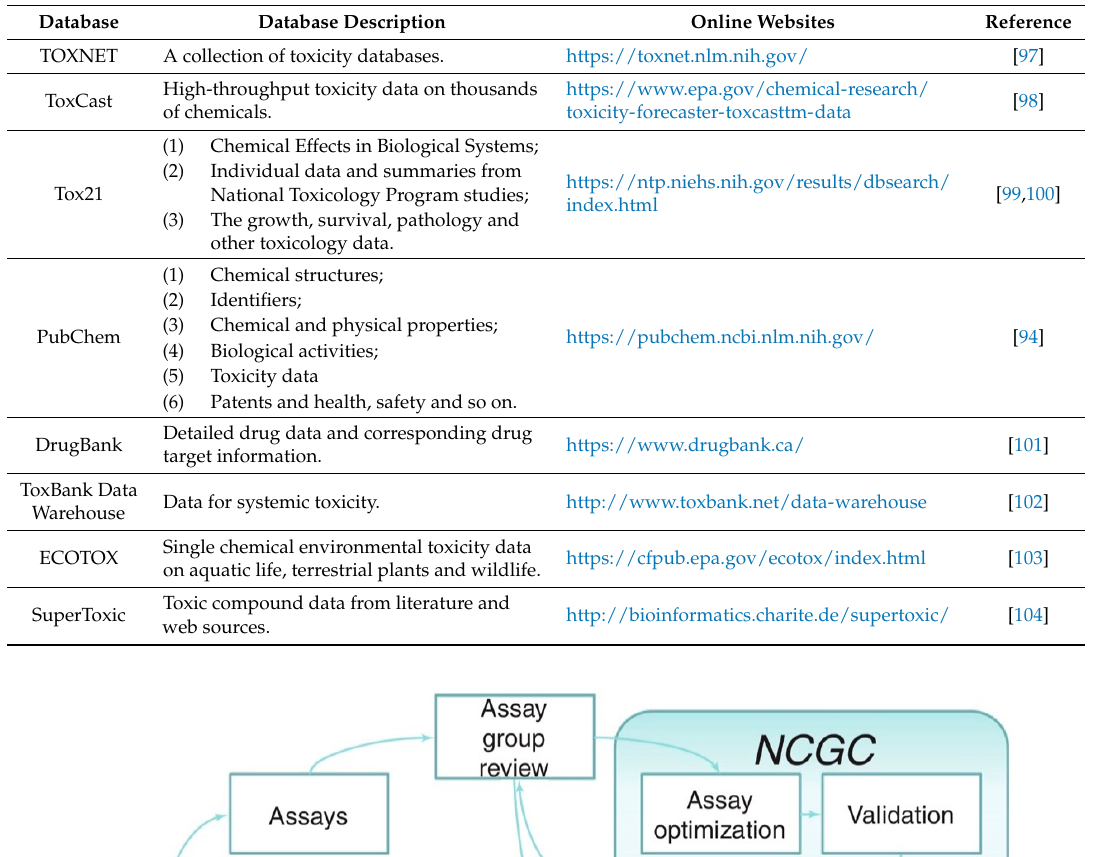
Table 2. The mainstream data resources of toxicity chemicals.